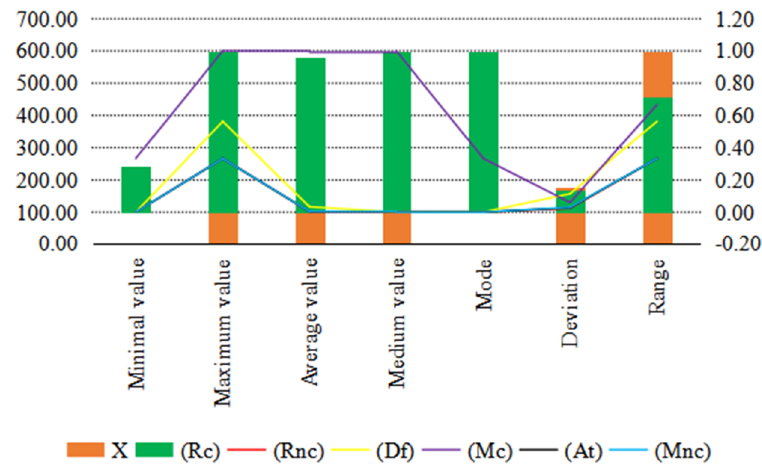
Figure 7. Analyses half of rational nodes when choosing defender strategies.